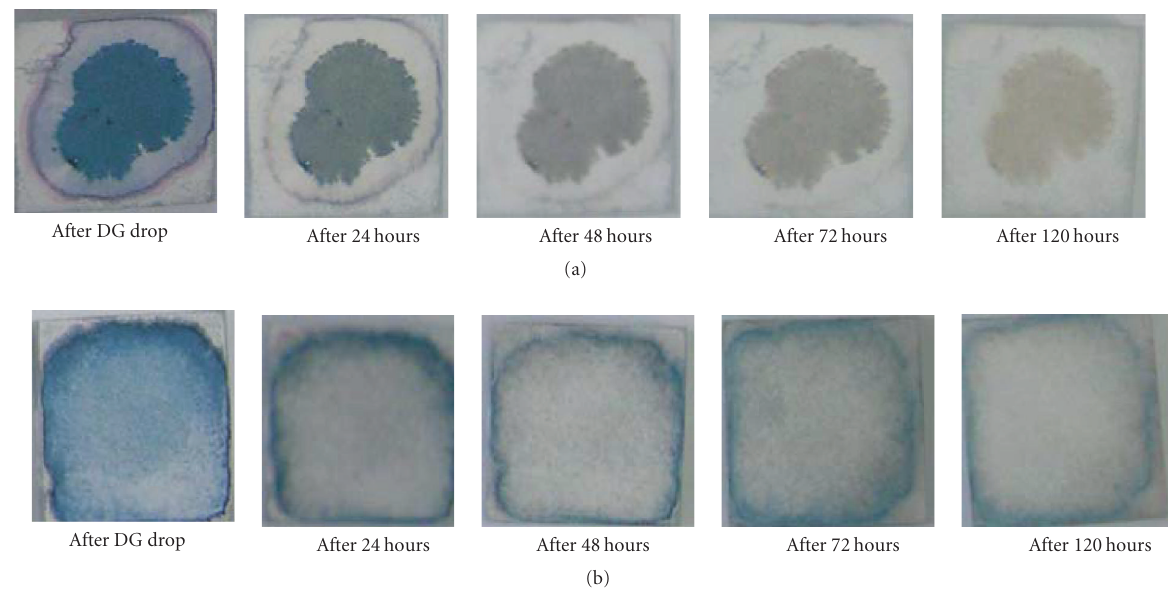
Figure 9: The photos of TiO 2 /N 500 placed on glass plate after sandblasting with adsorbed Direct Green 99 in time of visible light irradiation (a) without liquid glass layer and (b) with liquid glass